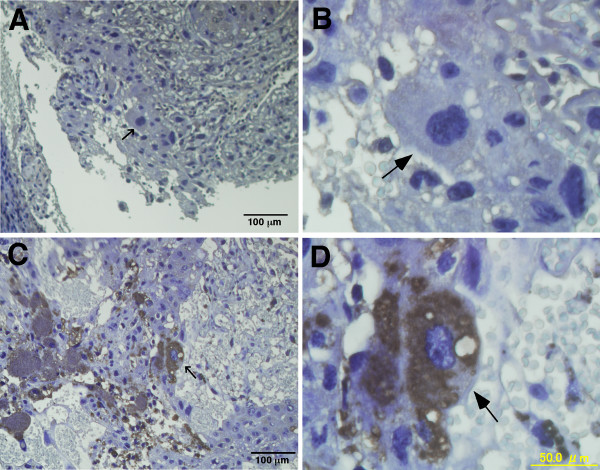
B. abortus predominantly invades into trophoblast giant cells in placenta. Placentas not used for bacterial culture were fixed in situ within uteri in 10% neutral buffered formalin and processed routinely for histologic examination and scoring using Meyer's hematoxylin stain. Specific labeling of B. abortus in placental sections was performed using the Dako EnVision System with anti-B. abortus rabbit serum and replicated bacteria are shown in brown. Normal (A and B) and infected placenta (C and D) are shown. Panels (B) and (D) indicate magnified images in panels (A) and (B). Arrows show trophoblast giant cells.